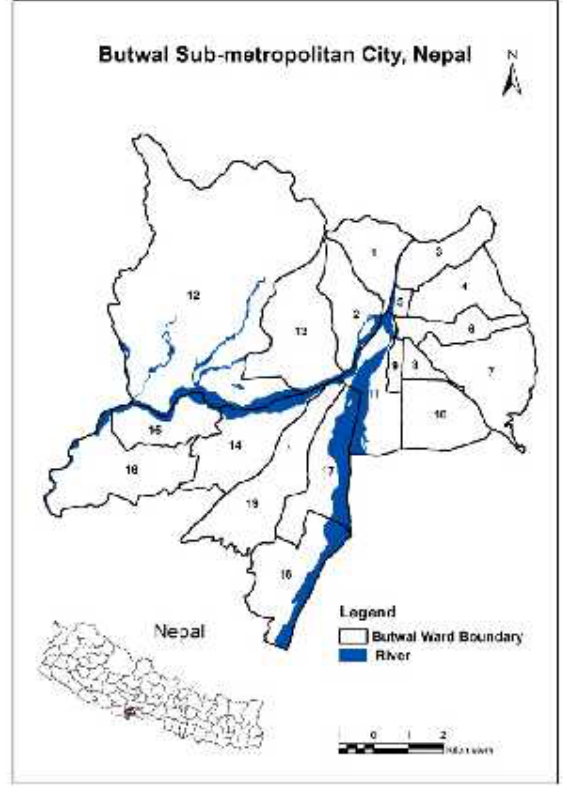
Figure 1: Location map of study